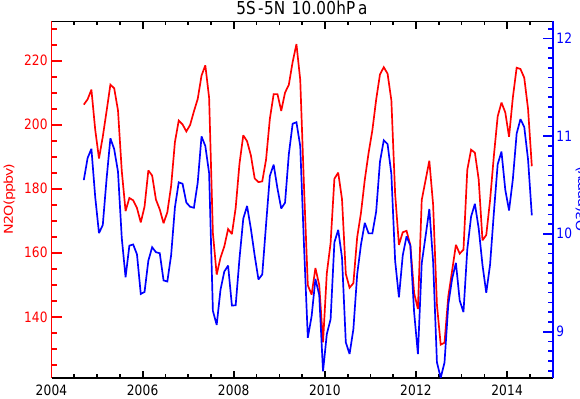
Figure 5. Monthly median N 2 O (red) and O 3 (blue) mixing ratios at 10hPa from MLS measurements between 5 ◦ S and 5 ◦